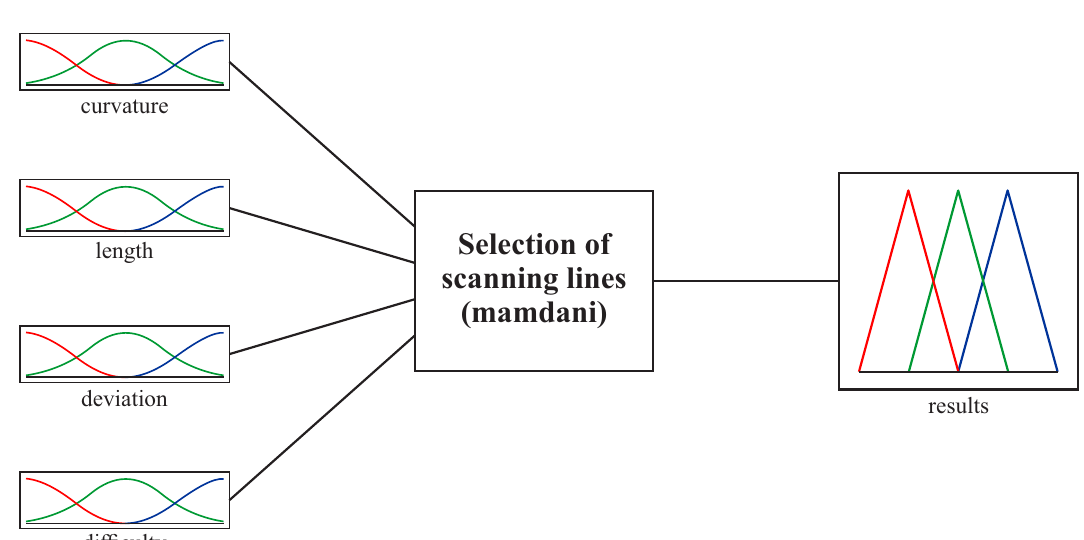
Figure 5. The structure of the first part of the expert system.